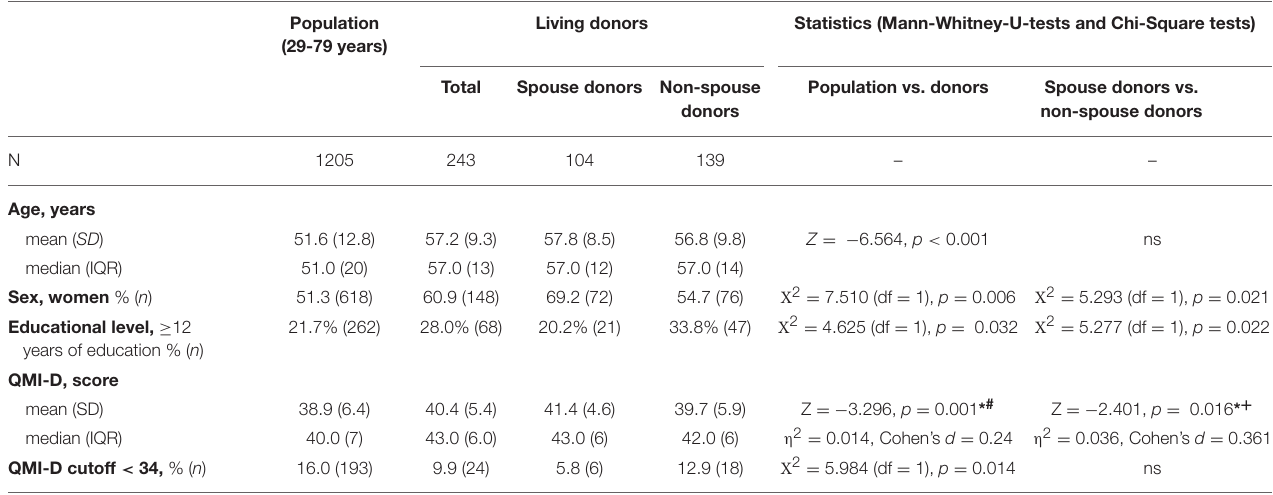
TABLE 1 | Comparison between population and donor sample and between spouse donors and non-spouse donors.